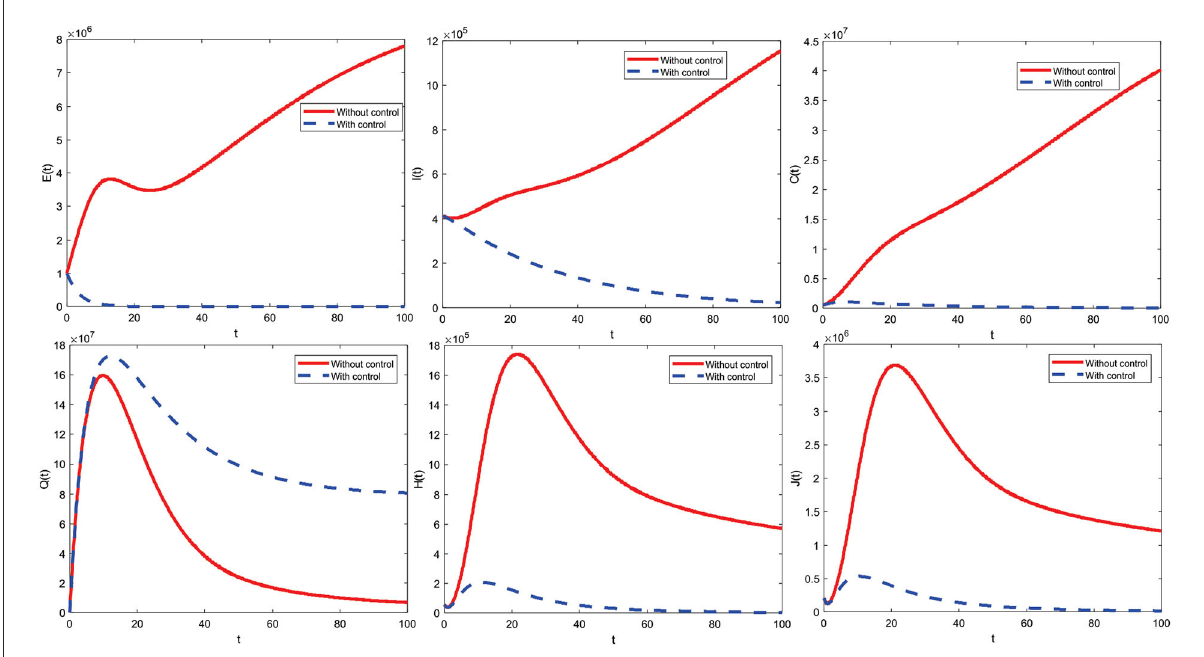
FIGURE7 The optimal control simulation results with u 1 6= 0.